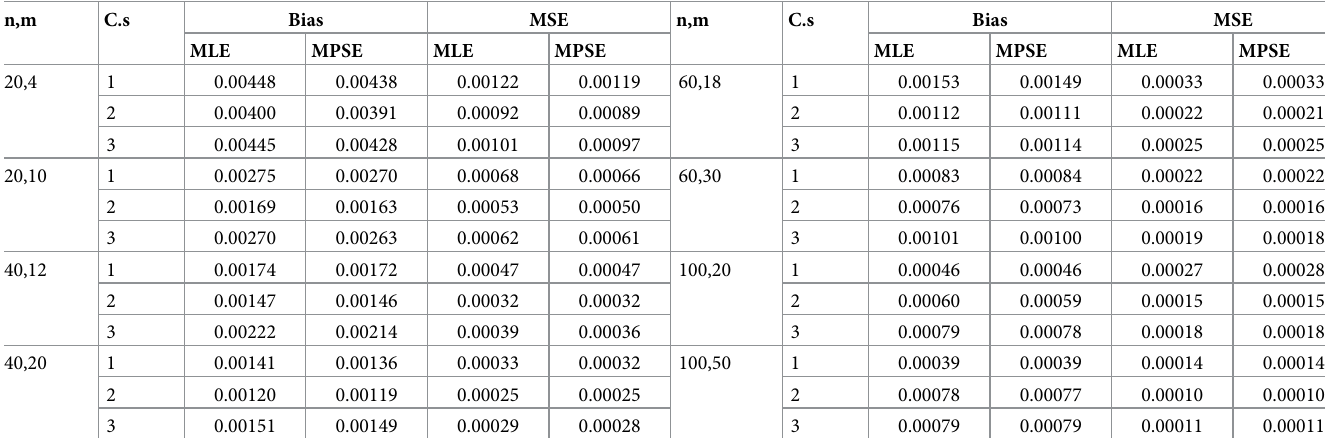
¼ X m for different censoring schemes when θ = 1 4